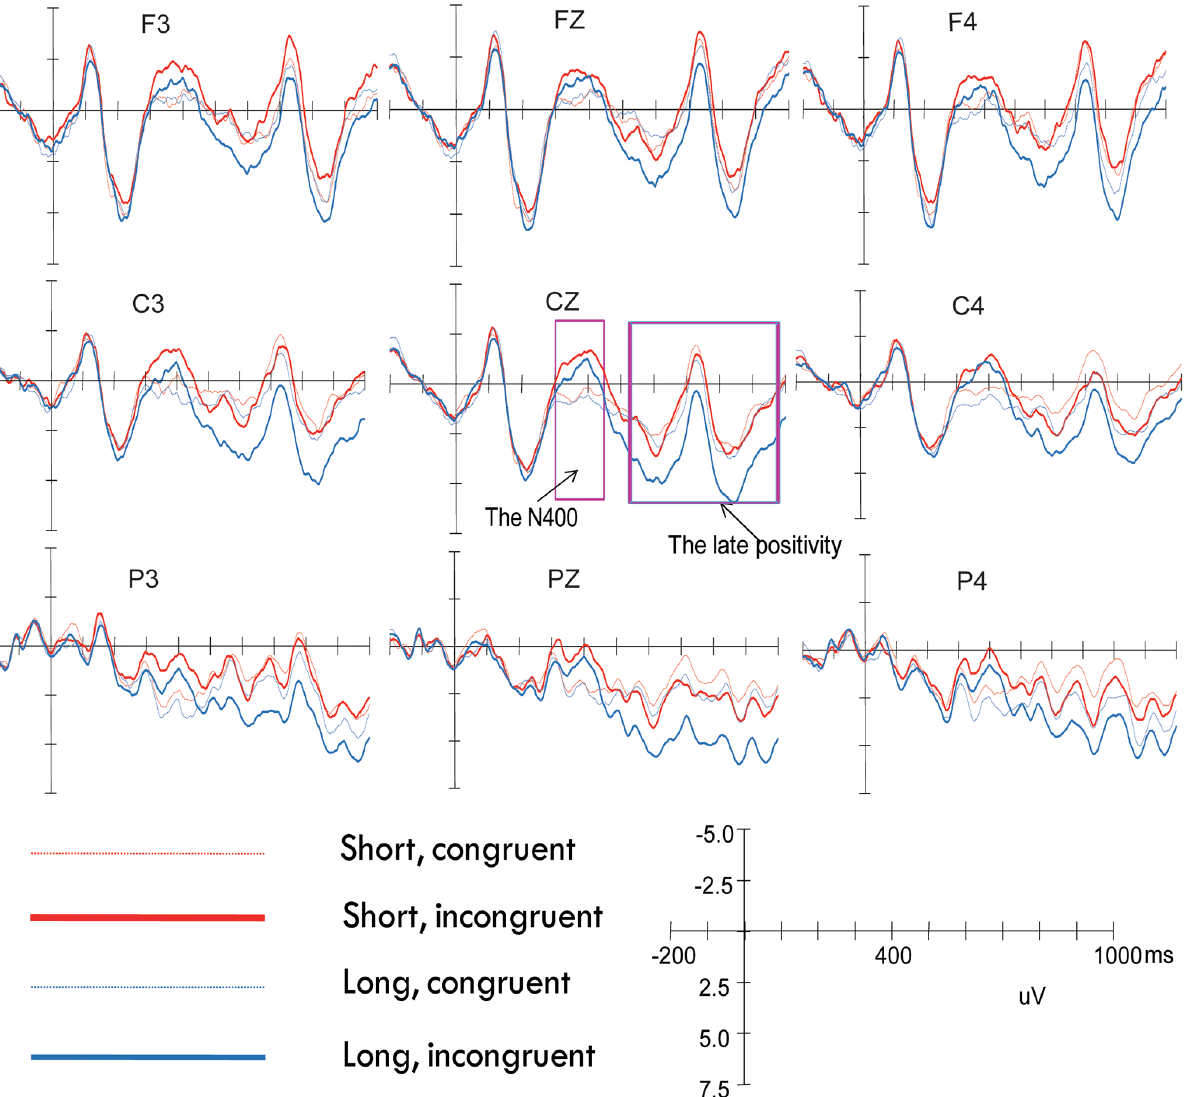
Fig 2. Grand average waveforms elicited by the four conditions at nine selected electrode sites. Waveforms are time-locked to the onset of the critical words and negative amplitude is plotted up.